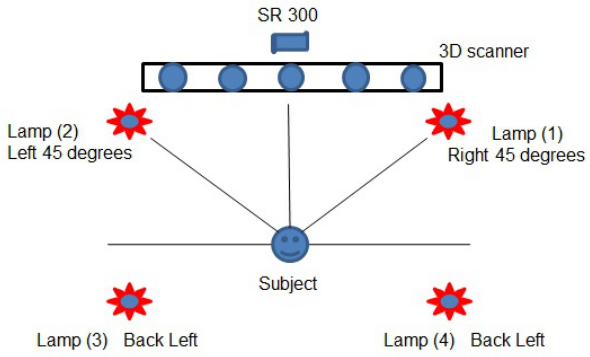
Figure 2. The cameras and lamps were located about 1 m and 1.5 m from the floor respectively and